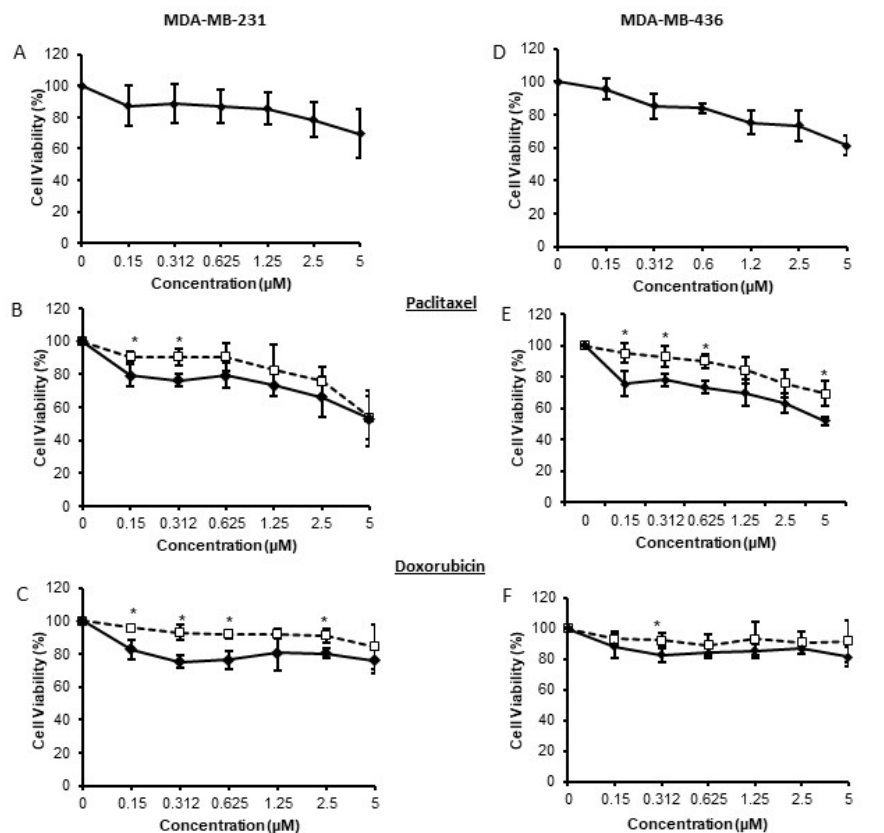
Figure 4. Inhibition of Brk’s kinase function increases cell sensitivity to chemotherapeutic agents. Triple negative MDA-MB-231 and MDA-MB-436 cells were seeded and allowed to adhere overnight in 96 wells plates. They were then treated with the Brk inhibitor Compound 4f alone ( A , D ) or in combination with paclitaxel ( B , E ) or doxrubicin ( C , F ) over a range of concentrations (0–5 µ m). In B–F, open squares represent cells treated with doxorubicin or paclitaxel only; closed diamonds represent cells treated with both 4f and the chemotherapeutic agent. Cell viability was determined by MTT assay and expressed as a percentage of the control (vehicle only) wells. The mean % survival (+/ − SD) of n = 3 experiments is plotted; * indicates p < 0.05.